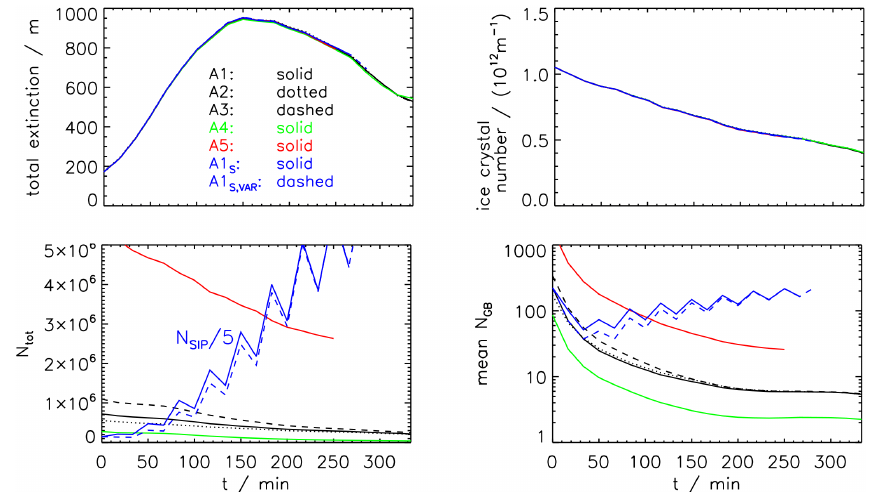
Fig. 3. Temporal evolution of total extinction E , total ice crystal number N , total SIP number N tot and mean SIP number per grid box for setups with different numbers of initial SIPs (see legend). Parameter settings of the simulation series are listed in Tables 1 and 2.